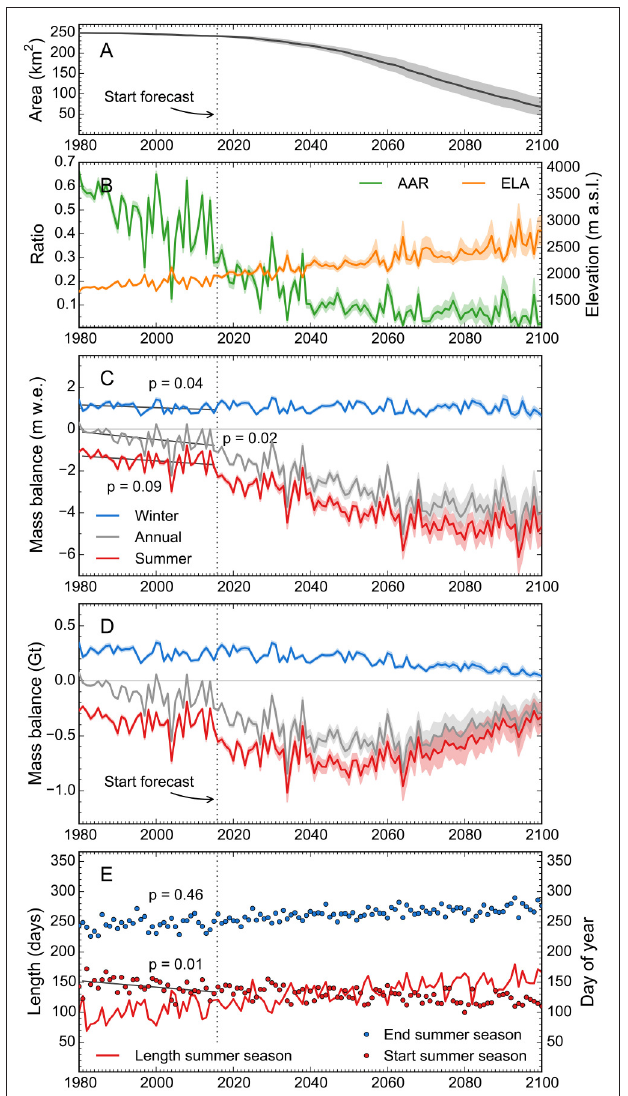
FIGURE 10 | Evolution of (A) glacier area, (B) AAR and ELA and (C–D) annual and seasonal glacier-wide mass balances (stratigraphic time system) during the period 1980–2100, using the RCP 8.5 scenario. (E) Evolution of the summer season length (left axis) and start/end dates of the summer seasons (right axis). In (A–D) , bold colored lines indicate the means of the results of all Monte Carlo runs while the semi-transparent areas delimit the corresponding standard deviations. In (E) , lines and points indicate the means of the Monte Carlo runs. In (C,E) , bold black lines show trend lines fitted over the hindcasting period, with p values indicating the degree of statistical significance.